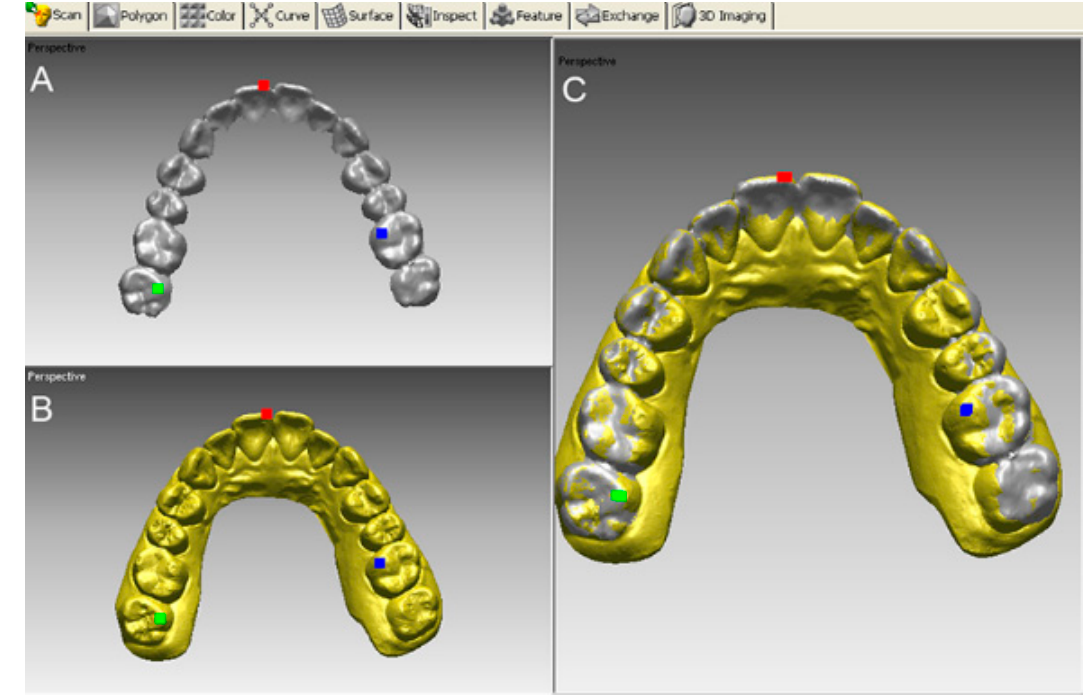
Figure 2. An example of best-fit alignment of a laboratory scanner model ( A ) and an iTero scan ( B ) of the maxillary arch. Initial registration of the two scans was achieved by designating three corresponding points. Best-fit alignment was completed using the “fine registration” function of the software program ( C ).